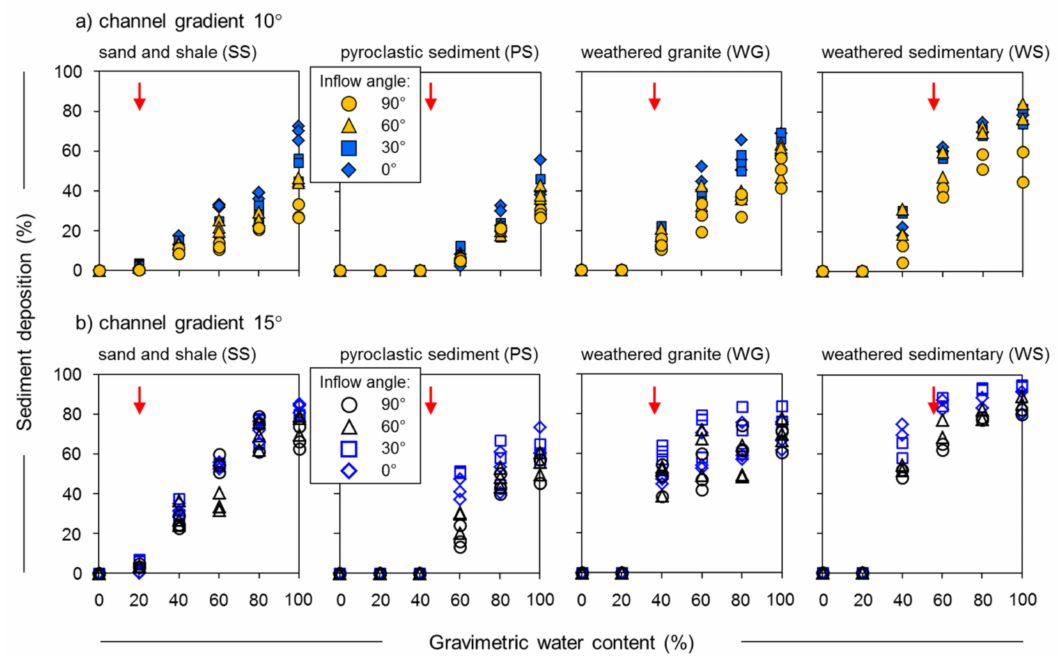
Figure 6. Sediment deposition at the outlet (section E ) for four sediment types. The arrows represent the different saturated water contents of sediments. ( a ) Sediment deposition for the 10 ◦ channel gradient; ( b ) sediment deposition for the 15 ◦ channel